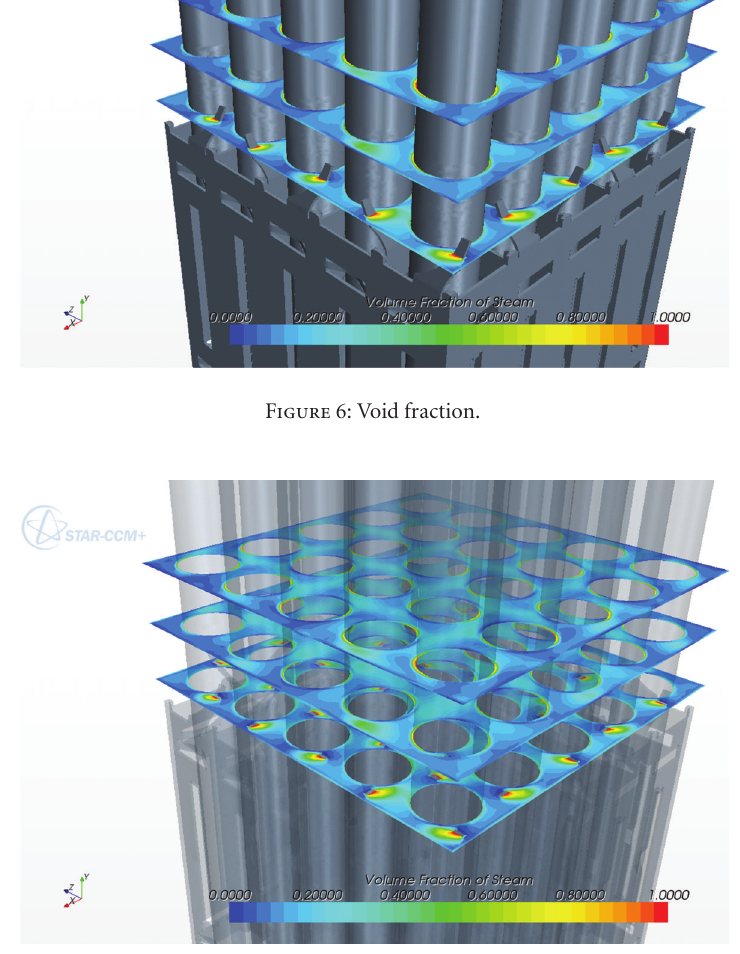
Figure 7: Void fraction downstream of spacer with mixing vanes.